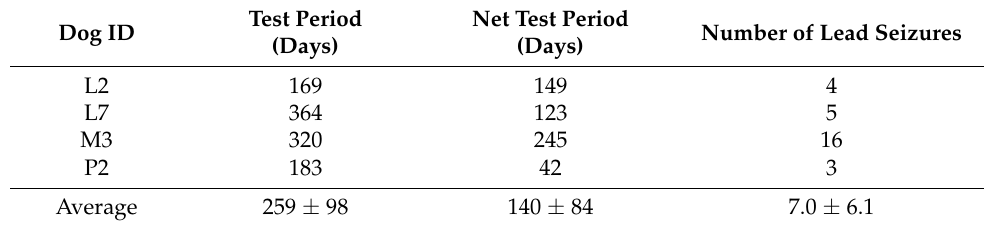
Figure 5. Retraining procedure: The classifier is retrained every week, and predictions are made for the next 7-day period (shown in green color). Vertical red lines indicate lead seizures. Training data contain most recent interictal segments (shown in shaded region). Initial Training pool 1 contains 2 preictal segments and 16 interictal segments. Training pool 2 is extended to include fresh interictal segments (for training). Training pool N contains 6 preictal segments, but only 5 recent ones are used for training. Table 2. Summary statistics for test